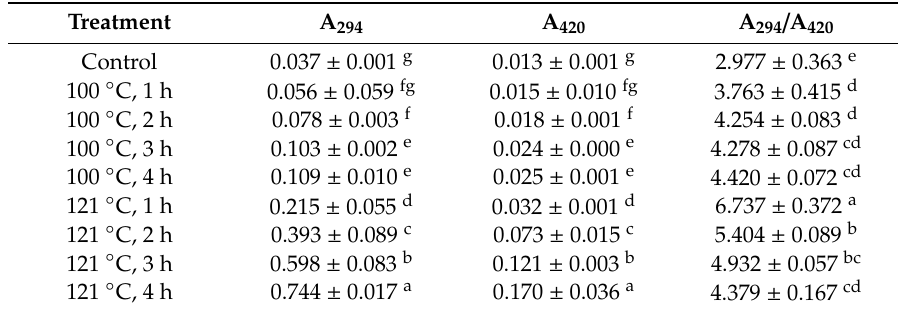
Table 1. Absorbance at 294 nm and 420 nm of water-soluble chitosan–glucose derivatives (WSCGDs) from di ff erent treatment times and temperatures *.